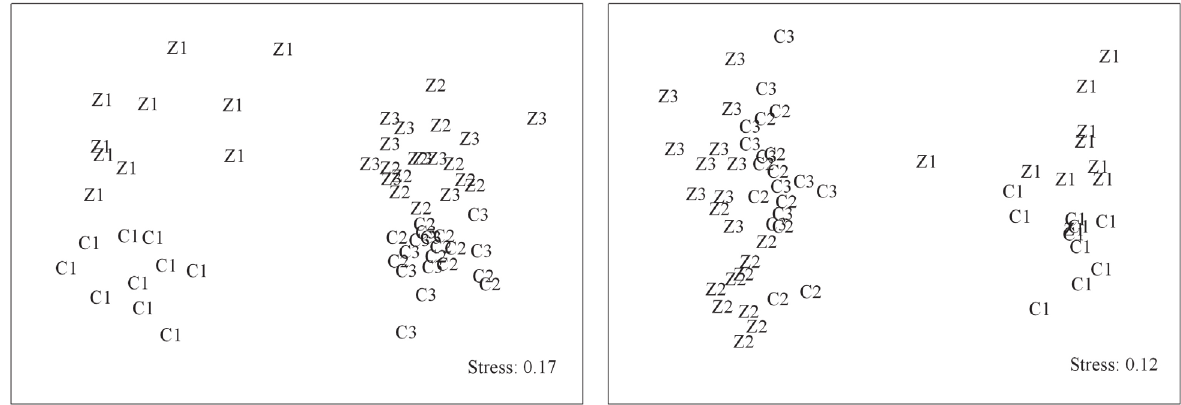
Fig . 3. – n-MDS ordination showing differences found between epiphyte assemblages growing on Caulerpa taxifolia (C) and Zostera capri- corni (Z) at the three study sites in (a) September and (b) October sampling.